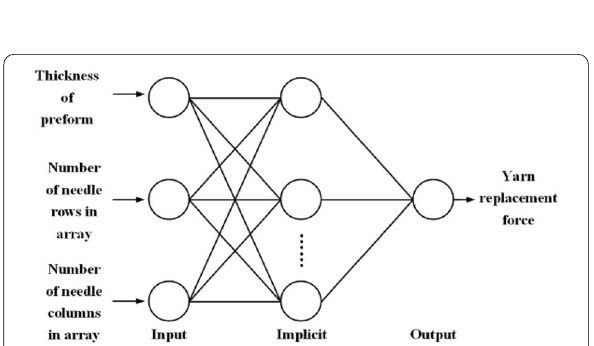
Figure 10 BP neural network model for cutting force